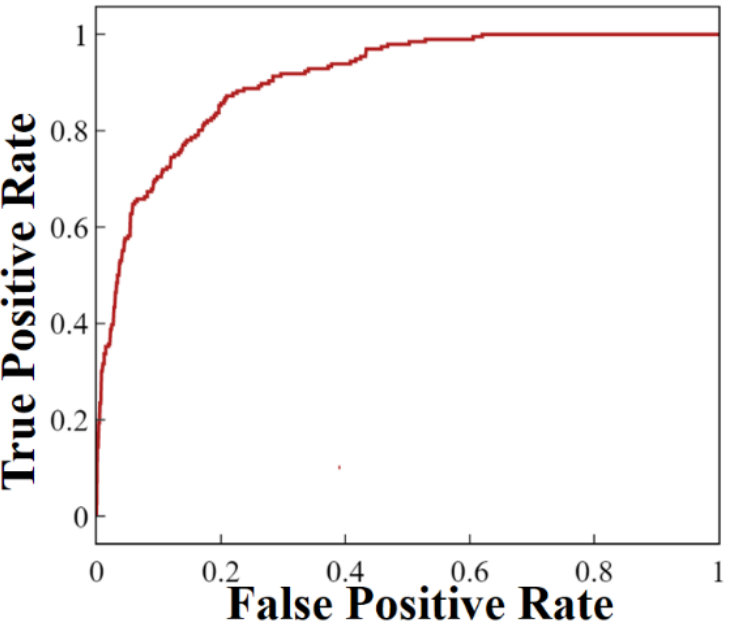
Figure 4. Receiver operating characteristic curve of the algorithmic model for the testing group ( n = 1091).